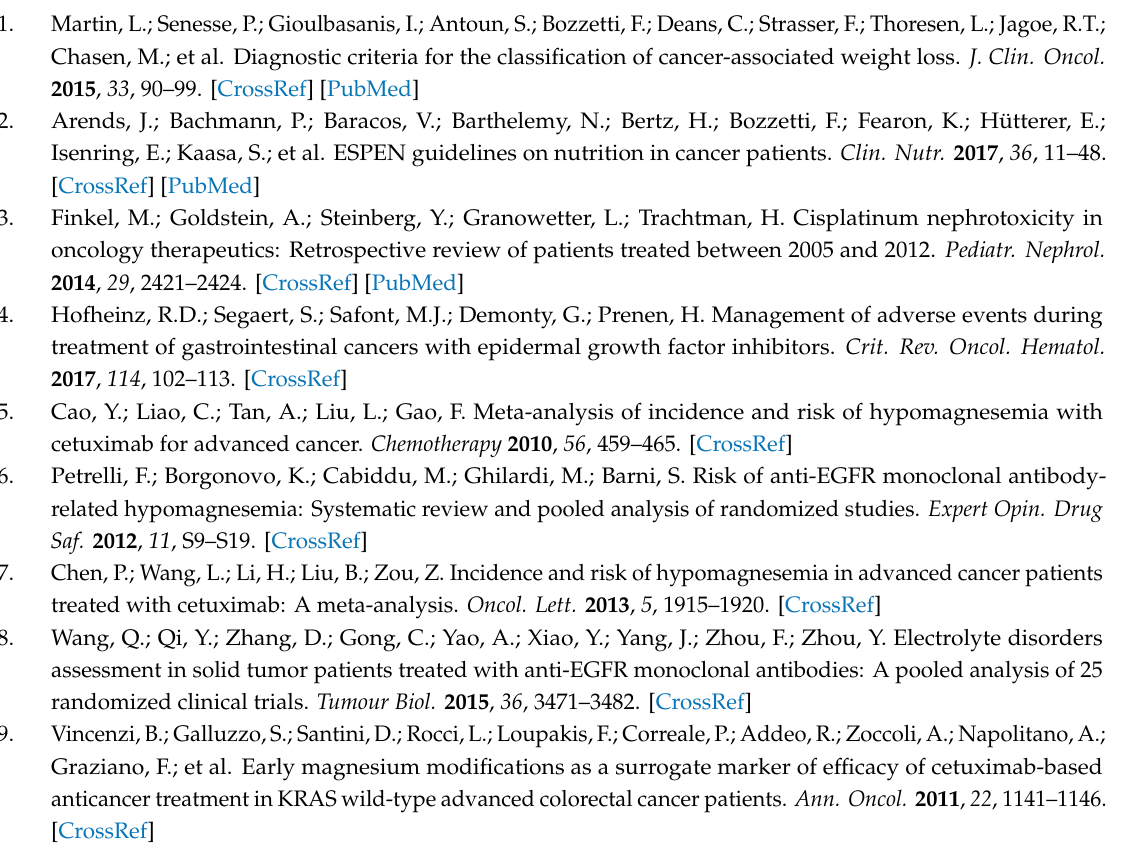
Figure S1: full scan of the original blot for TRPM6 shown in Figure 1; Figure S2: full scan of the original blot for TRPM6 shown in Figure 2; Figure S3: phosphorylation of ERK1 / 2 in unstimulated CaCo2 treated with CTX in control or Mg-supplemented medium; Figure S4: growth curve of CaCo-2 cells in control or Mg-supplemented